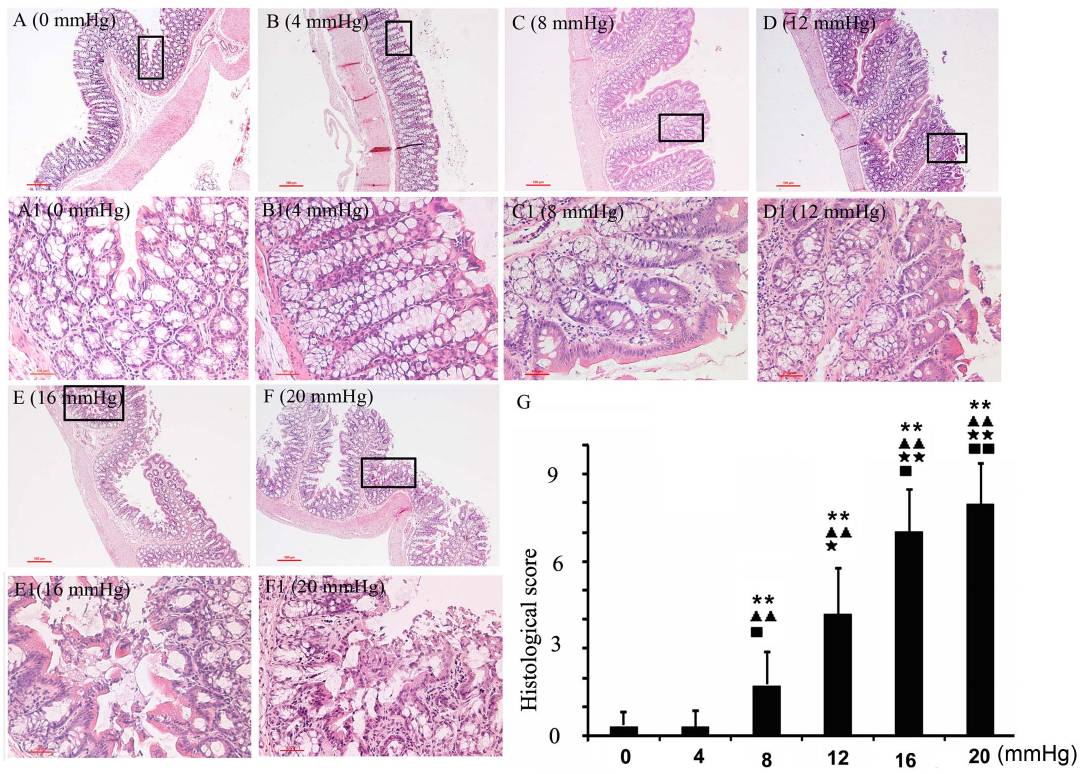
Figure 4. The effects of the different grades of nitrogen pneumoperitoneum on intestinal histologic damage. A–F (0–20 mmHg, 6 100): Morphological changes under the different grades of nitrogen pneumoperitoneum. The parts in the black box are magnified and listed from A1 to F1 (0–20 mmHg, 6 200). As the intra-abdominal pressure (IAP) increased, the severity of the histologic changes increased. At 8 mmHg, nitrogen pneumoperitoneum induced slight inflammatory cell infiltration. When the IAP reached 20 mmHg, almost no intact intestinal mucosa was observed. G: Histological scores in the different groups. Compared with the 0-mmHg group, the 8-, 12-, 16-, and 20-mmHg groups had significantly higher histological scores. All data are shown as means 6 SD. **P , 0.01, vs. 0 mmHg; mm P , 0.01, vs. 4 mmHg; w P , 0.05, ww P , 0.01, vs. 8 mmHg; & P , 0.05, && P , 0.01, vs. 12 mmHg.